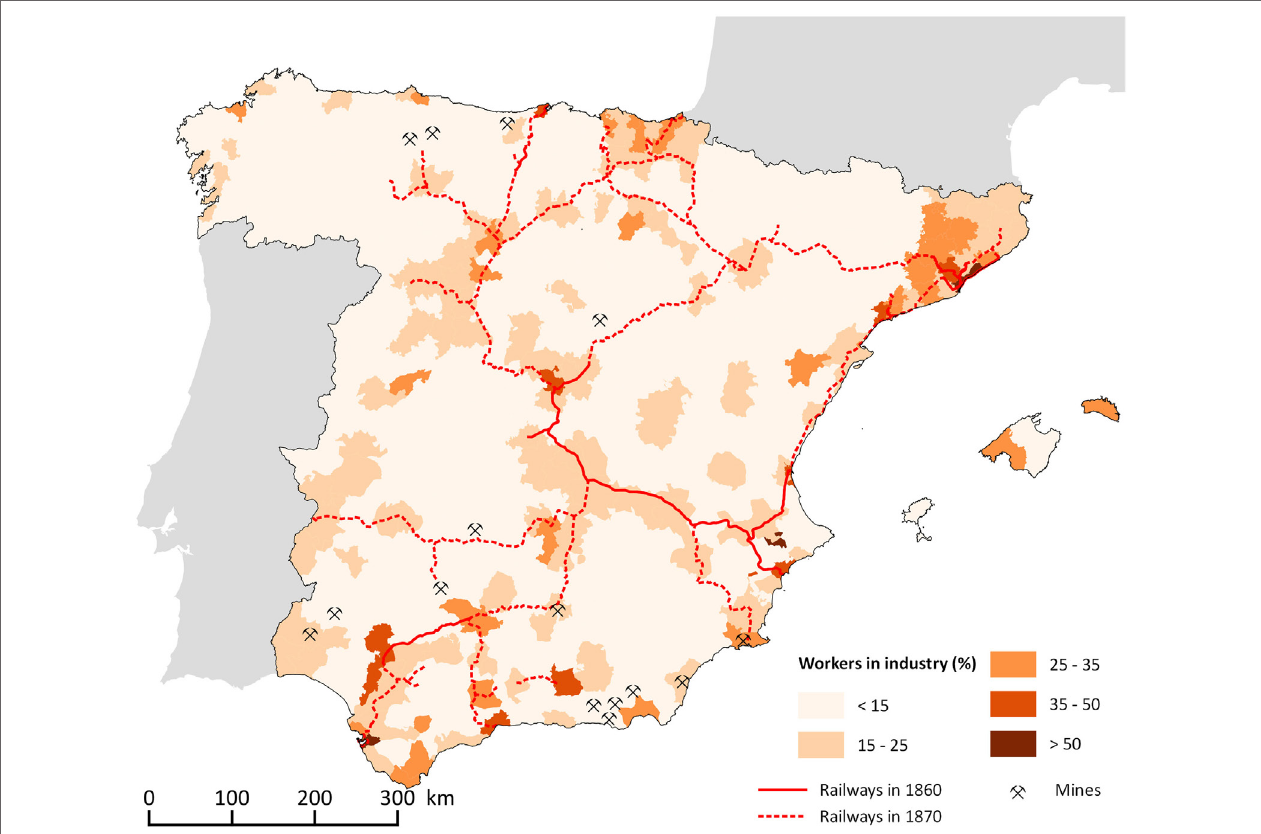
FigUre 4 | Percentage of industrial workers and artisans over the total occupied population in Spain in 1860, by judicial district. Source: Own